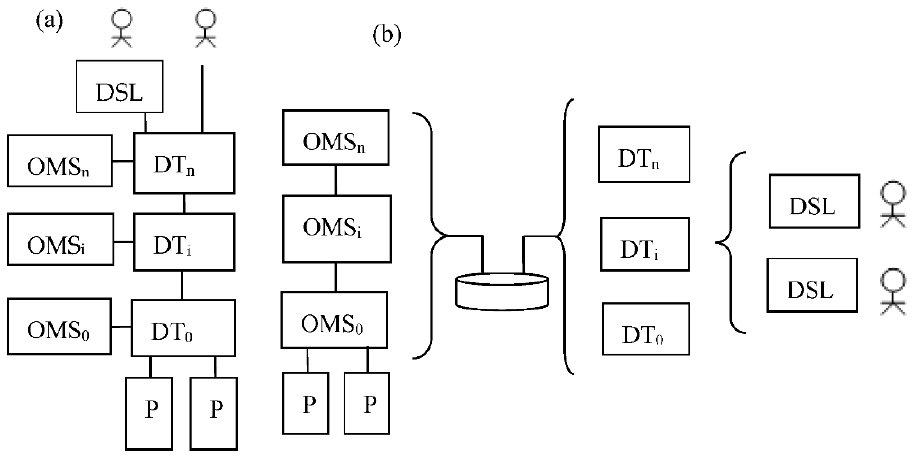
Figure 8. OMSM deployment.